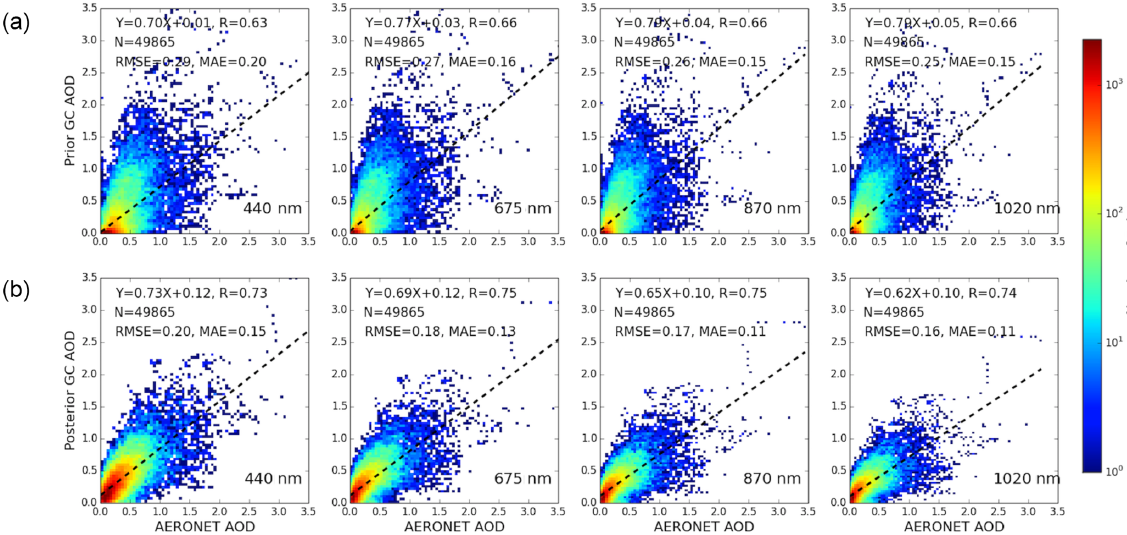
Figure 17. Density scatter plots of 1-year GEOS-Chem-simulated AOD using the prior emissions (a) or the posterior emissions (b) versus AERONET-measured AOD at 440, 675, 870 and 1020nm at 28 sites. The AOD data were aggregated into 80 bins for both the x and y directions spanning the range from 0.0 to 3.5 for AOD at four wavelengths. The number of matched pairs ( N ), correlation coefficient ( R ), root-mean-square error (RMSE) and mean absolute error (MAE) are shown on each panel.